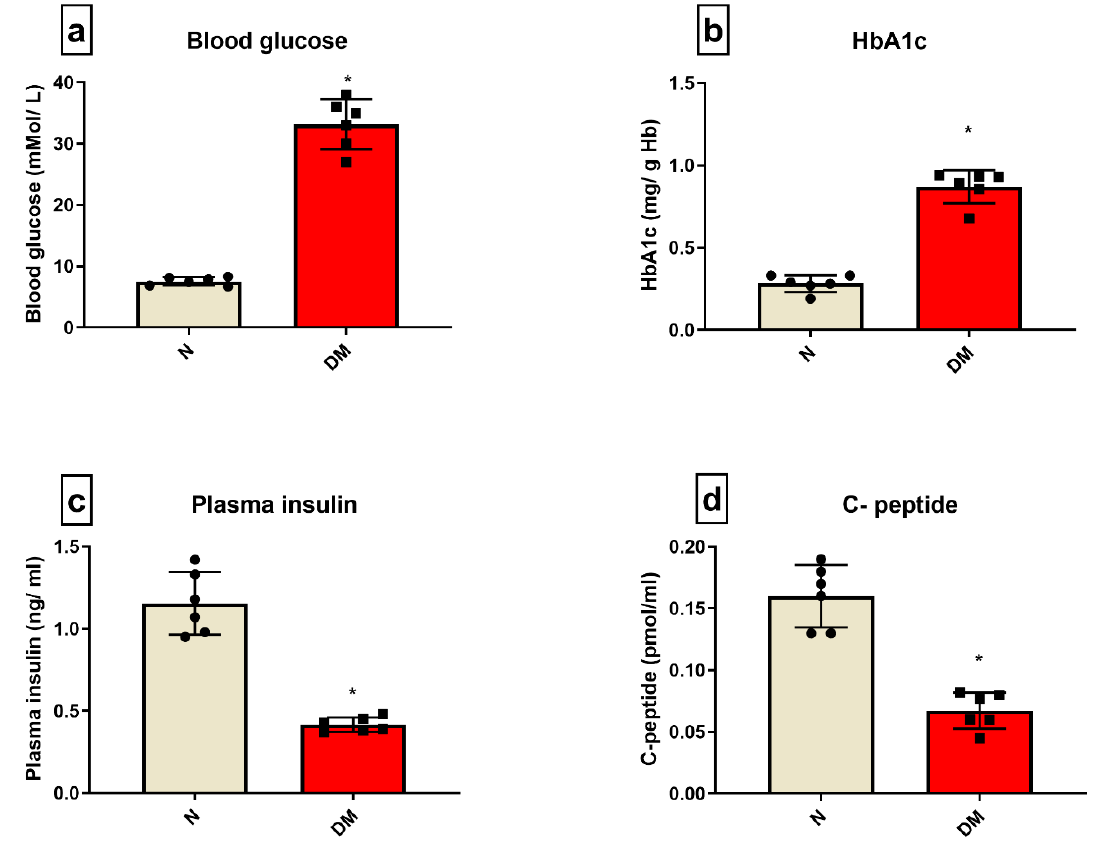
Figure 1. DM characterization: The characteristics of DM were evaluated in the rat blood by assessing the levels of ( a ) blood glucose; ( b ) HbA1C; ( c ) plasma insulin; ( d ) C-peptide. The graphs represent mean ± SD values. * p < 0.05 vs. N. Table 2. Effect of I/R on cardiac function in diabetic hearts: The impact of diabetes on cardiac I/R were evaluated by the hemodynamic changes LVDP (left ventricular diastolic pressure); RPP (rate pressure product = heart rate × LVDP) and ± dp/dt maximum/minimum force of contraction. The data are represented as mean ± SEM. * p < 0.05 vs. I / R